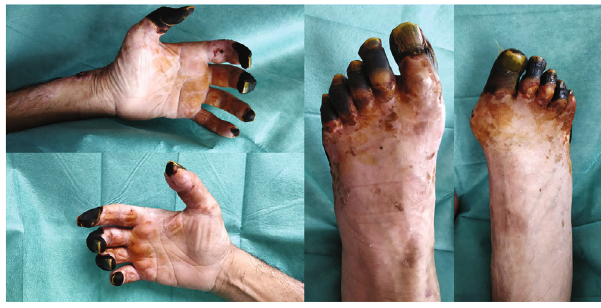
Figure 3: Case 2